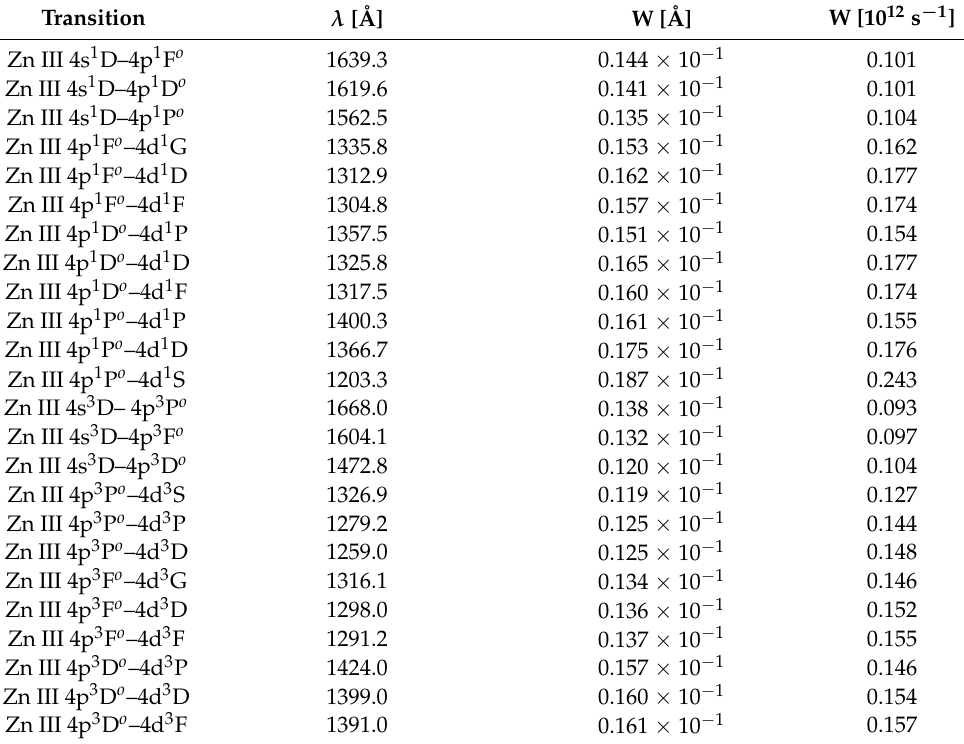
Table 2. This table gives electron-impact broadening (Stark broadening) Full Widths at Half Intensity Maximum (W) in [Å] and in [10 12 s − 1 ] units for Zn III spectral lines, for an electron density of 10 17 cm − 3 and T = 10,000